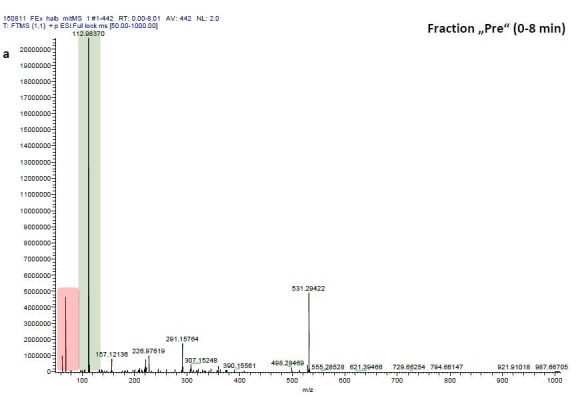
ESI-MS data of the HPLC fractions leading to daytime depths of Daphnia magna which do neither statistically differ from the negative nor from the postive control and the corresponding spectra of a blank run.ESI-MS spectrum extracted from the time window corresponding to fraction: Author response image 2“Pre”, Author response image 4“8”, Author response image 6“9” in Author response image 1 and Author response image 3, 5, 7 the corresponding mass spectra from a previous blank run measured in the negative ionization mode. MS/MS of m/z=531.3 lead to the appearance of a product ion of m/z=96.9598 which indicated the presence of a sulfate in the precursor ion (Author response image 8).